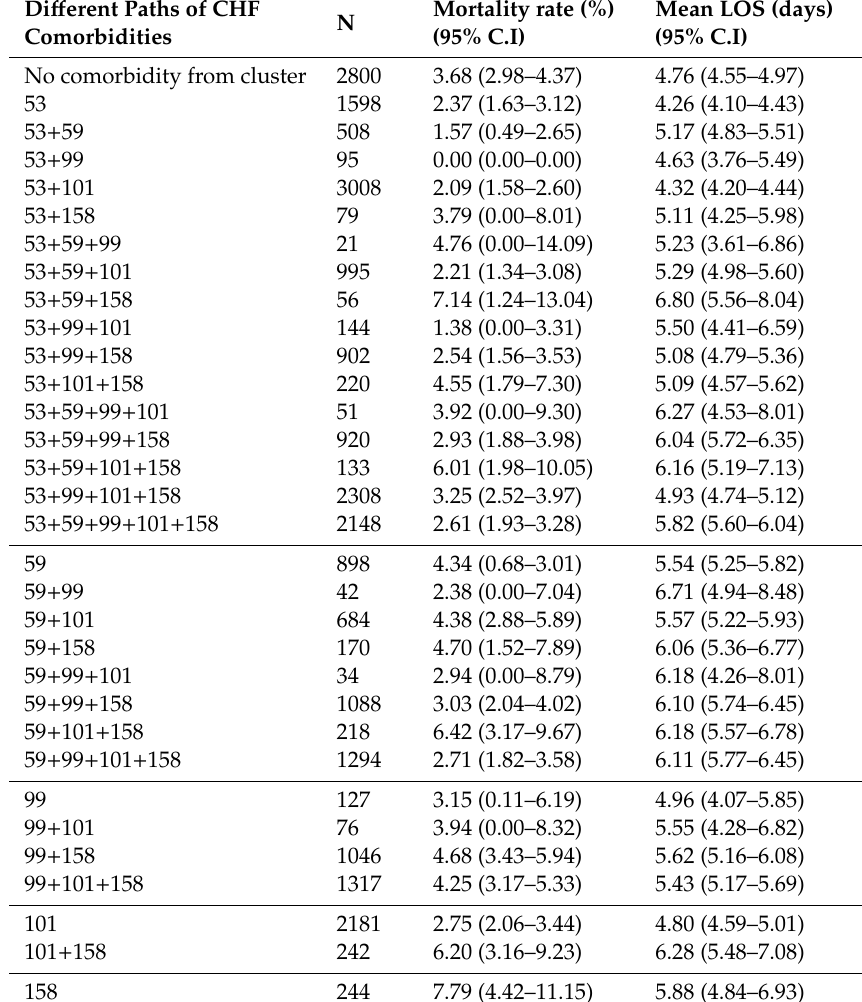
Table 6. Mortality rate and mean LOS for every CHF Comorbidity combination within Cluster